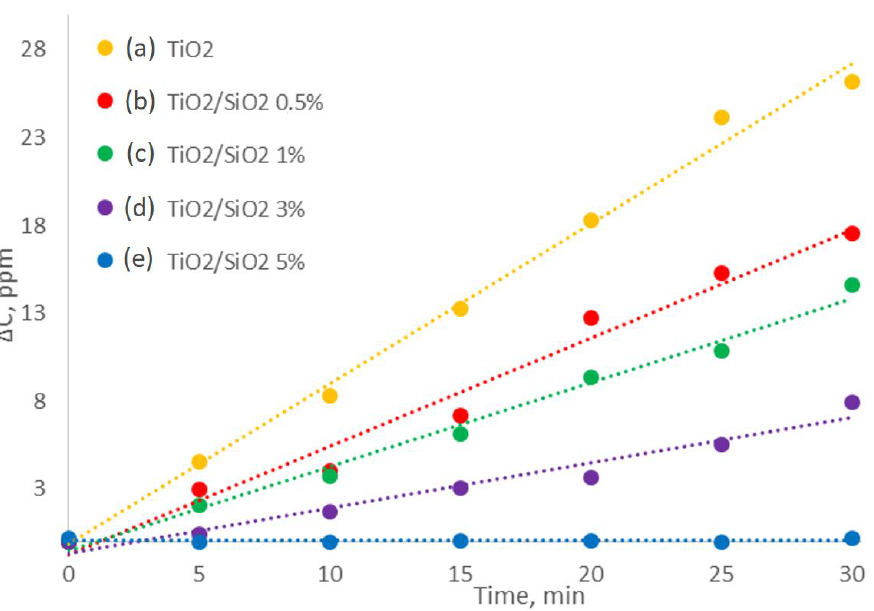
Figure 2. Measured photocatalytic activity of ( a ) TiO 2 100% and TiO 2 /SiO 2 multicompound nanoparticles with ( b ) TiO 2 /SiO 2 99.5/0.5, ( c ) TiO 2 /SiO 2 99.0/1.0, ( d ) TiO 2 /SiO 2 97.0/3.0 and ( e ) TiO 2 /SiO 2 95.0/5.0.